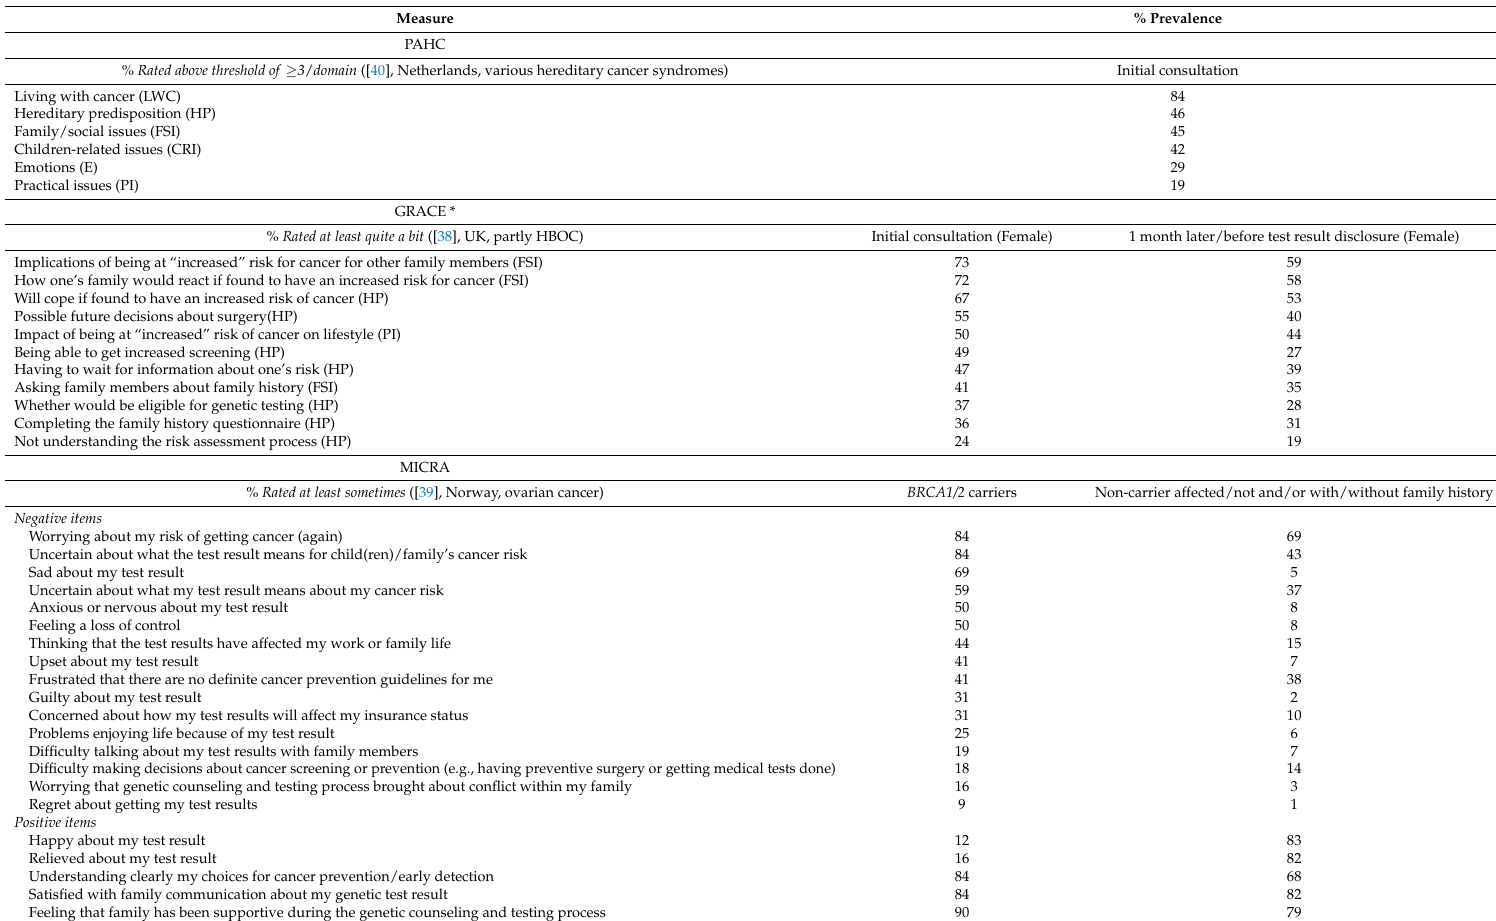
Table 4. Literature review—Prevalence of